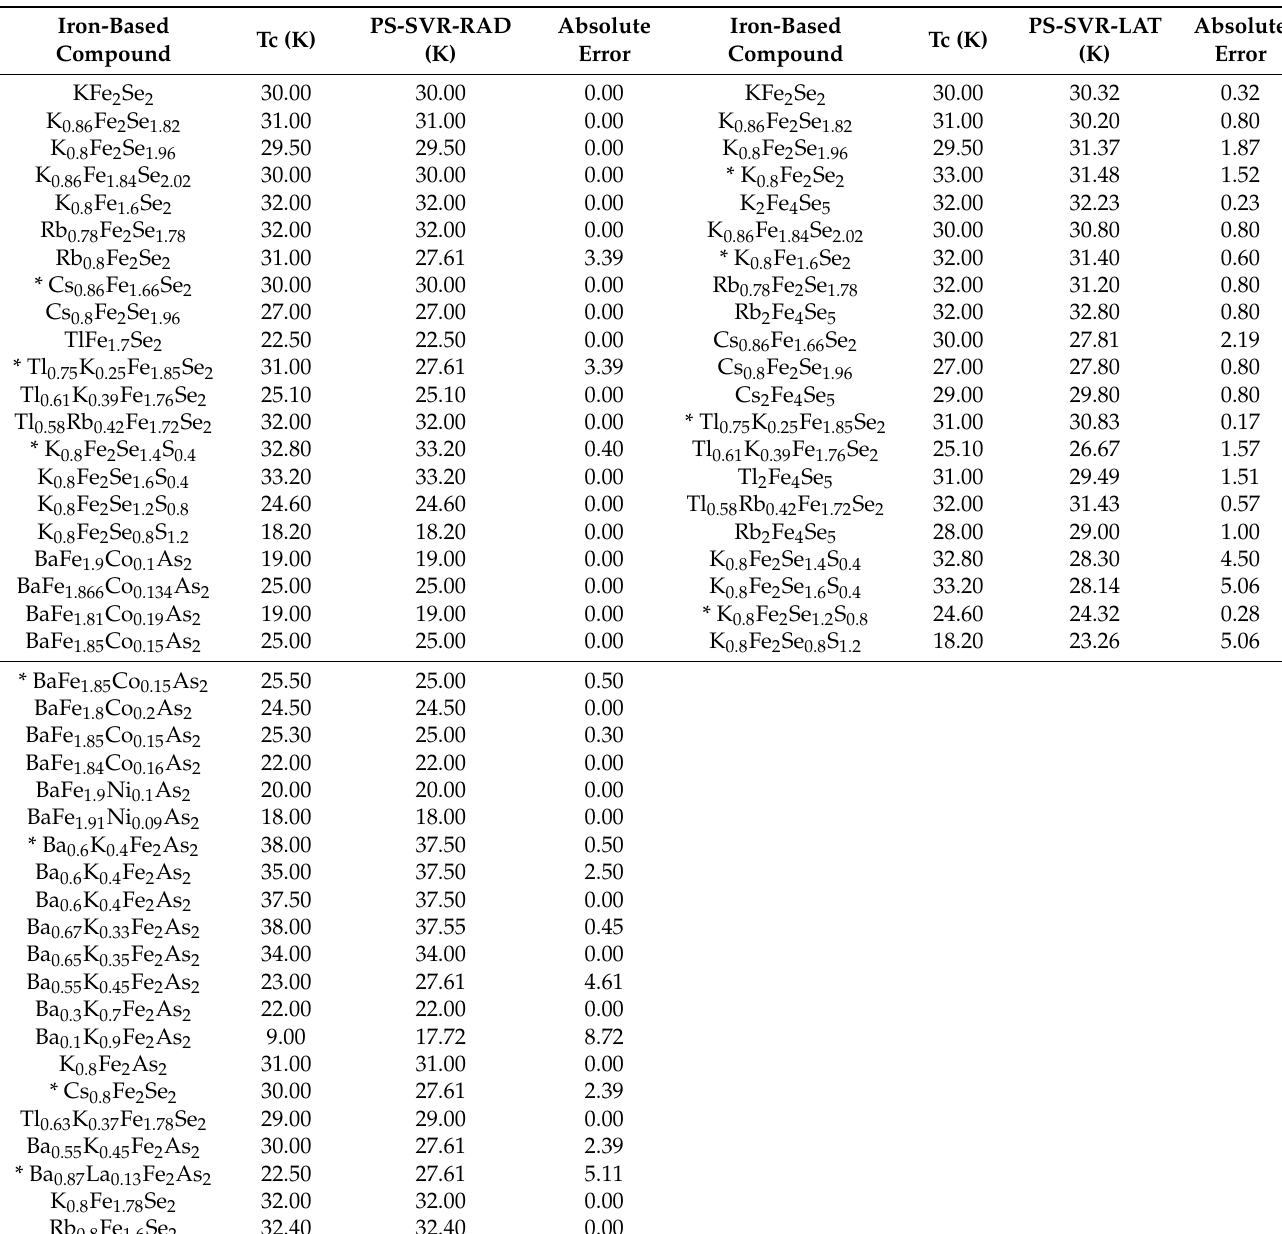
Table 3. Outcomes of the developed hybrid models and their comparison with the measured values [29–31].